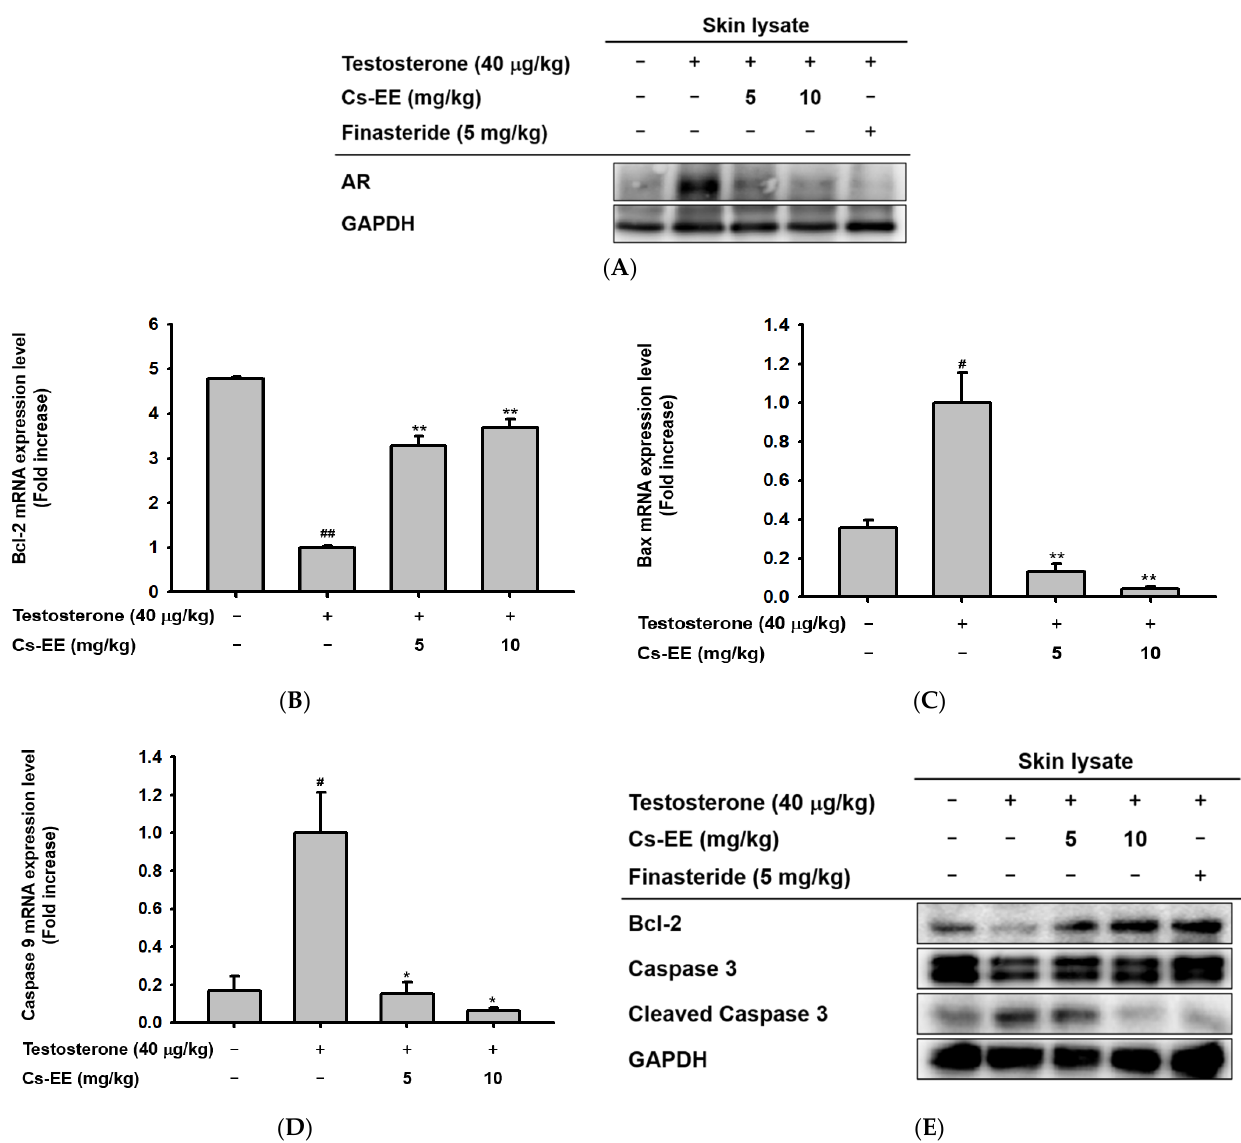
Figure 4. Androgen and apoptosis inhibition efficacy of Cs-EE at both the mRNA and protein levels in a testosterone-induced alopecia mouse model. ( A ) The protein level of androgenic receptor was also confirmed from skin lysate. GAPDH was used as a control protein. ( B – D ) The mRNA expression levels of Bcl-2, Bax, and caspase 9 in skin lysate were measured using quantitative real-time PCR. GAPDH was used as a control gene. € The protein level of Bcl-2 and the activation of caspase 3 in skin lysate were also determined by Western blotting. All data ( B – D ) are expressed as the mean ± standard deviation. # p < 0.05 and ## : p < 0.01 compared with the normal group, * p < 0.05 and ** p < 0.01 compared with the Cs-EE-untreated